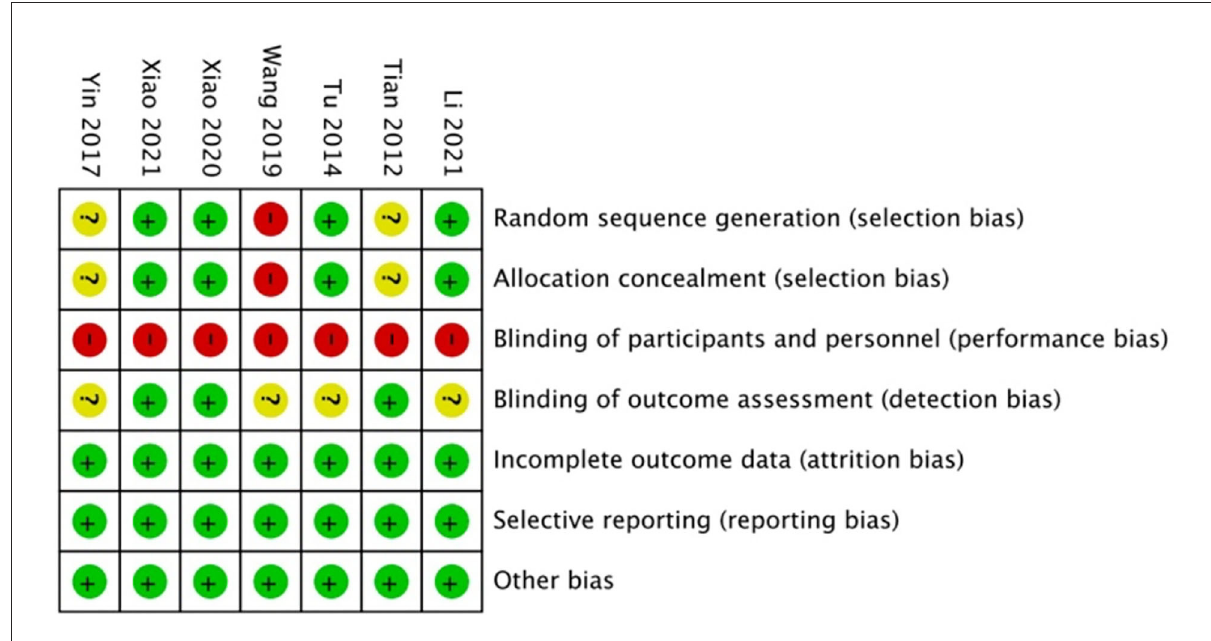
FIGURE2 Risk of bias summary: review authors’ judgments about each risk of bias item for each included